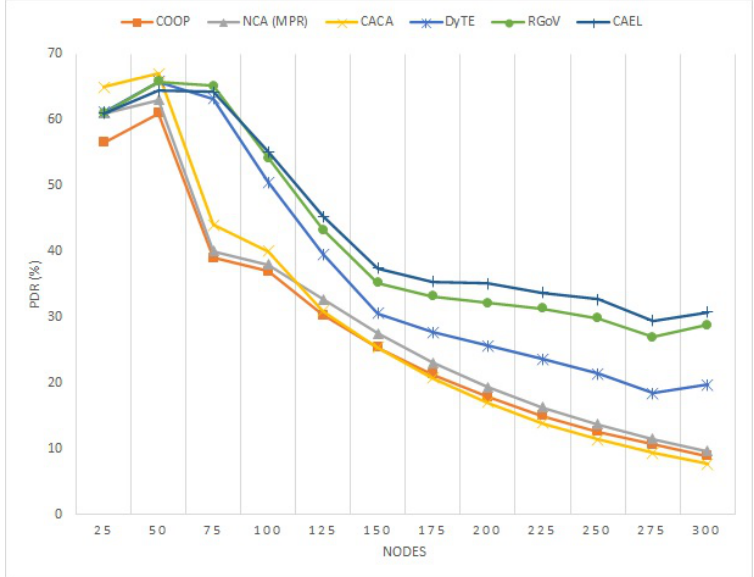
Figure 8. Packet delivery ratio against various number of